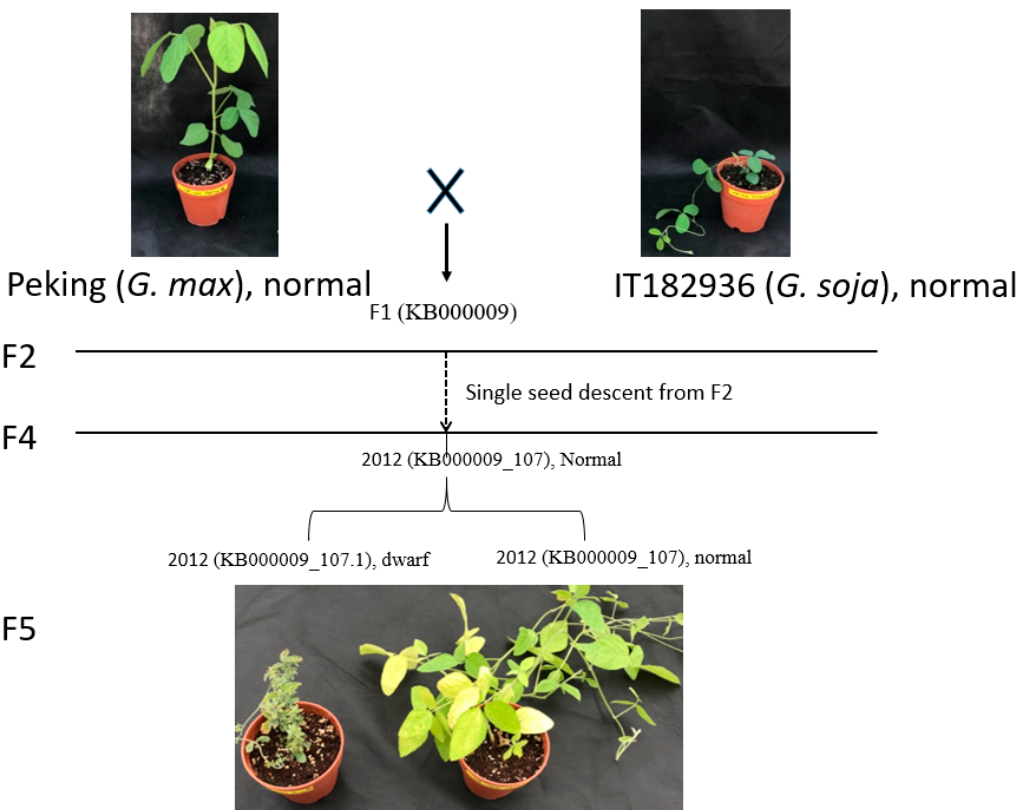
Figure 2. Schematic representation of RIL lines obtained from the cross of the cultivar soybean Peking and wild relative soja; both parents have normal phenotype as shown in the top. The plants in the bottom represent the normal and dwarf lines obtained in this cross.